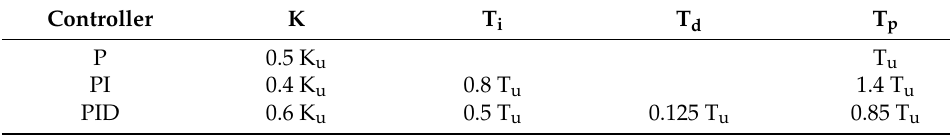
Table 4. Controller parameters for the Ziegler–Nichols frequency response method.